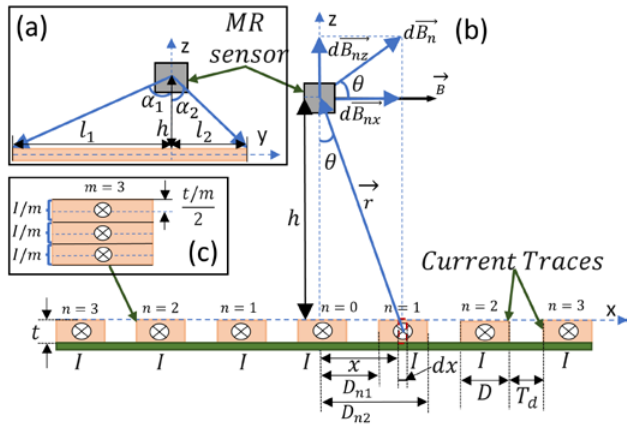
Figure 3. Analytical model to compute the magnetic field present in the sensor area: ( a ) Length correction of the magnetic field in the sensor area based on the distance from the linear trace ends; ( b ) Magnetic field components generated by the current through the trace and dimensional parameters; ( c ) Layered trace thickness parameters. Note that the model takes into account that there is an odd number of traces that generate the magnetic field and the central trace is denoted as n = 0.